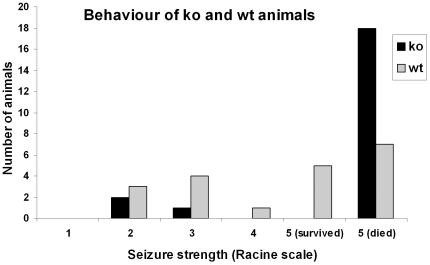
Different behaviour and survival of knock out and wild type animals.Graph showing the number of animals as a function of seizure strength demonstrates that knock out animals had more severe seizures compared to wild types and never survived tonic-clonic (Racine 5) seizures.